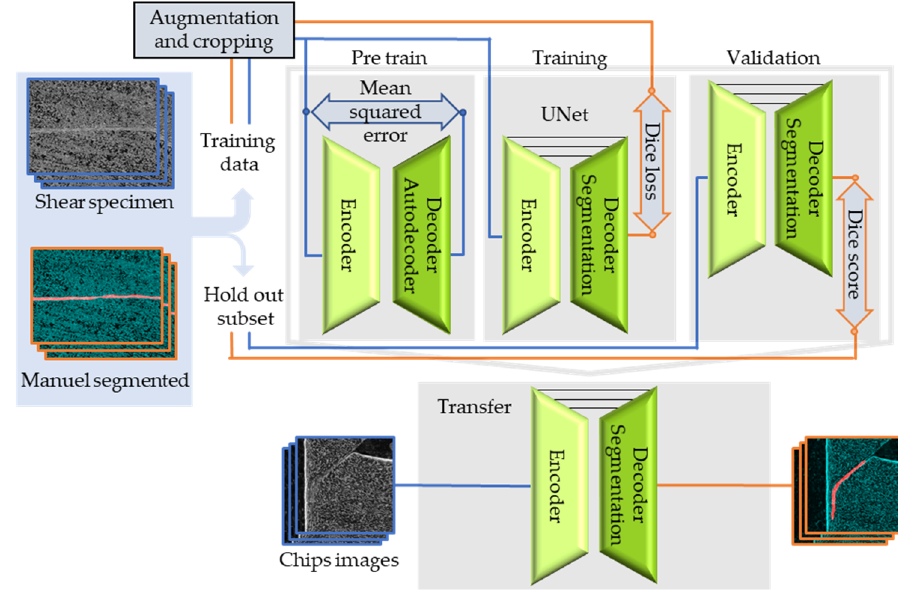
Figure 2. Sequence diagram of the deep learning approach.